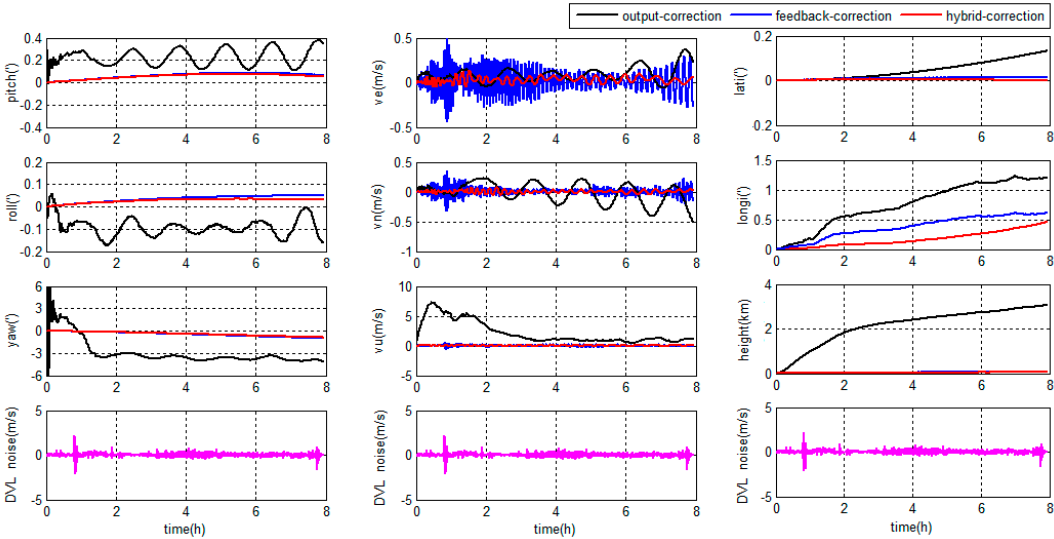
Figure 18. Integrated navigation errors in the middle latitude regions.